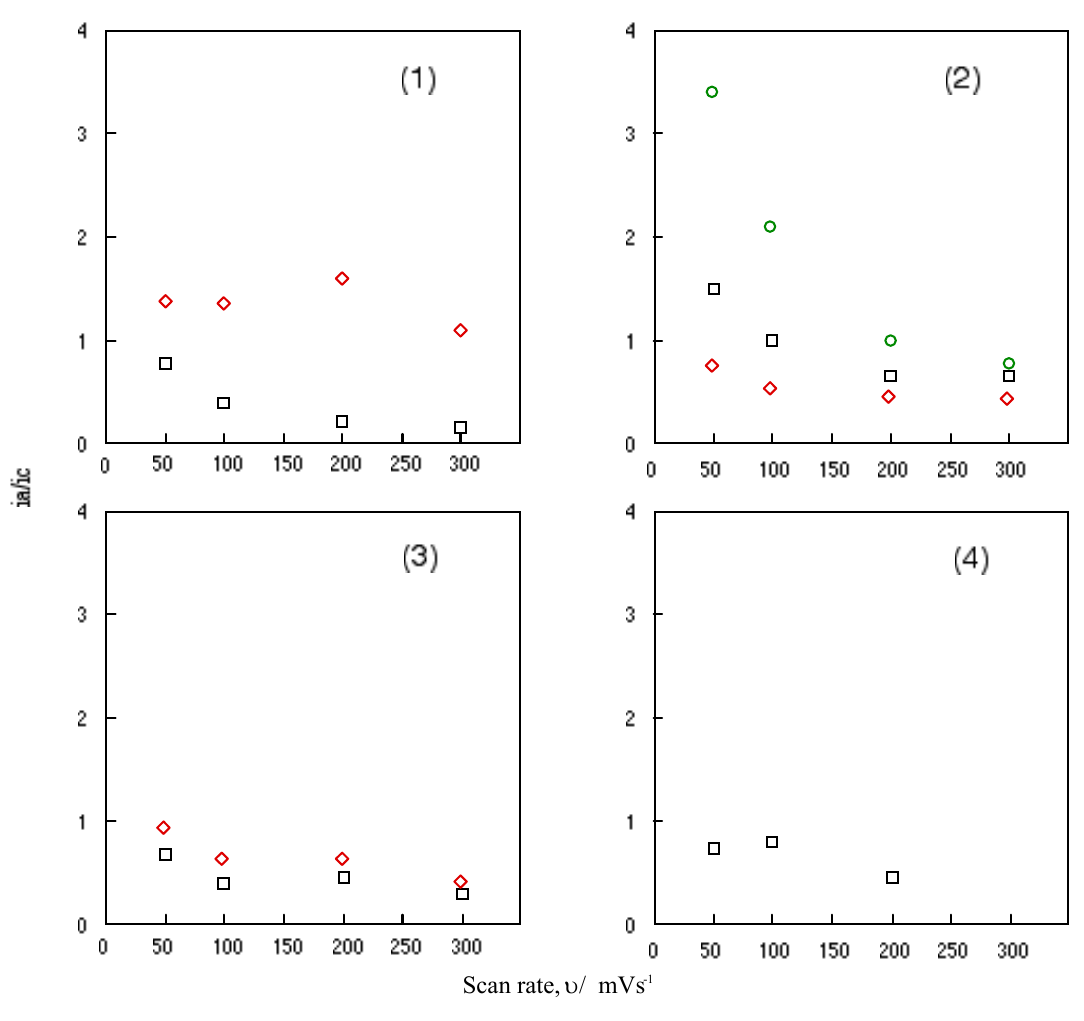
Figure 6. Change in the anodic to cathodic current ratio with scan rate for cobalt phthalocyanine derivatives. (1) Cobalt phthalocyanine tetrasulfonic acid. (2) Cobalt phthalocyanine octacarboxylic acid. (3) Cobalt octakis(hexoxymethyl)phthalocyanine. (4) Cobalt anthraquinocyanine. □ : First redox couple. (cid:31): Second redox couple. ○ : Third redox